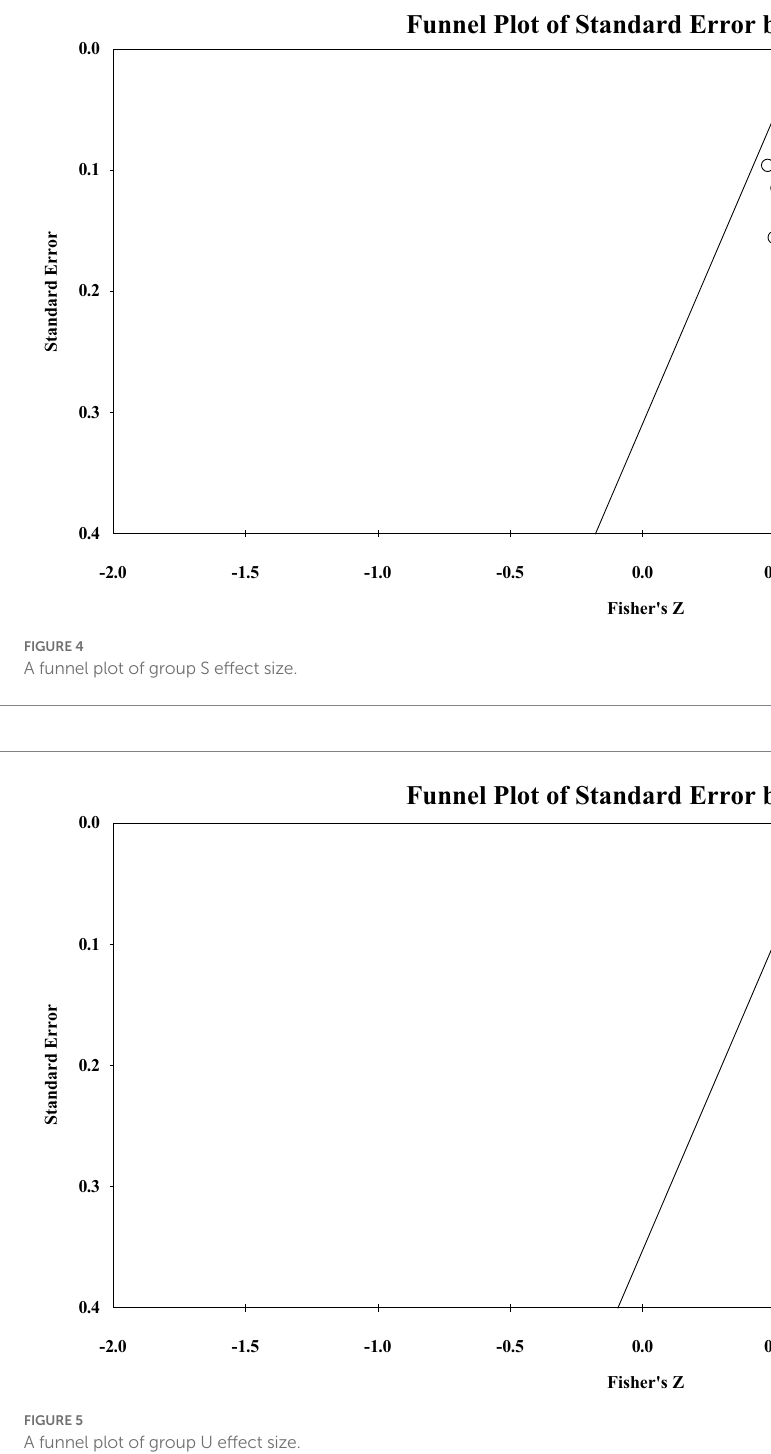
FIGURE 5 A funnel plot of group U effect